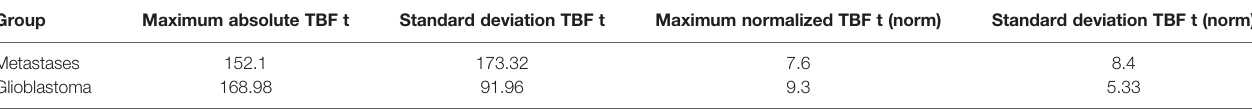
TABLE 1 | Average values of blood fl ow in metastatic and glioblastoma subgroups. Group